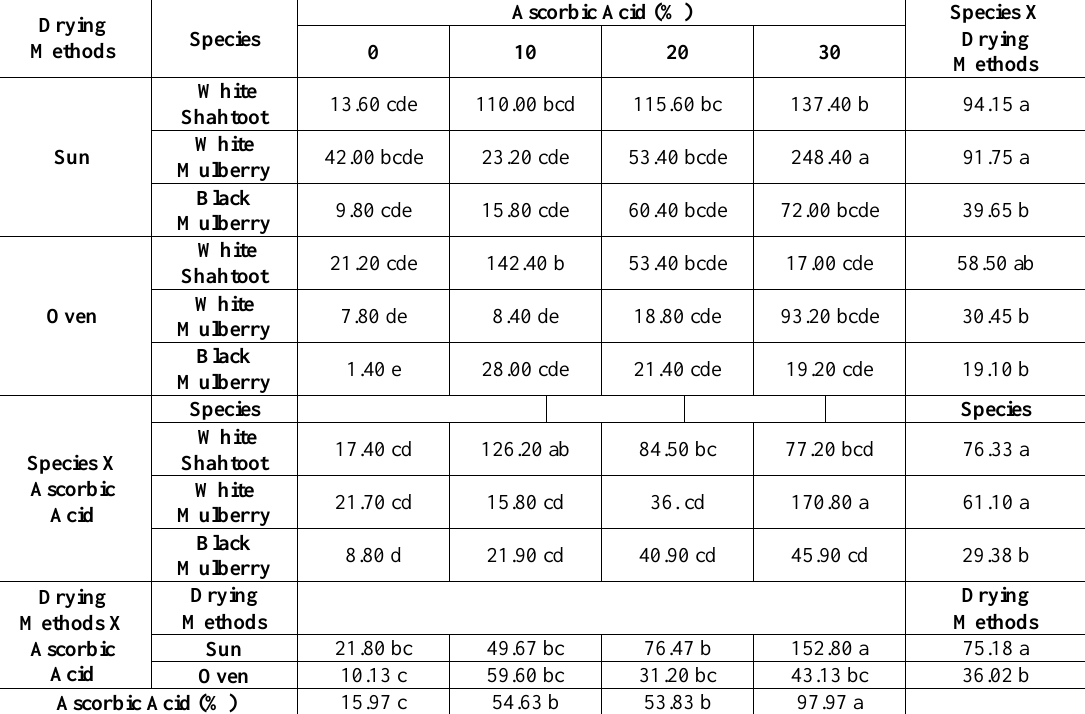
Table 5. Effect of ascorbic acid concentrations and drying methods and their interactions on polyphenol oxidase activity of three mulberry